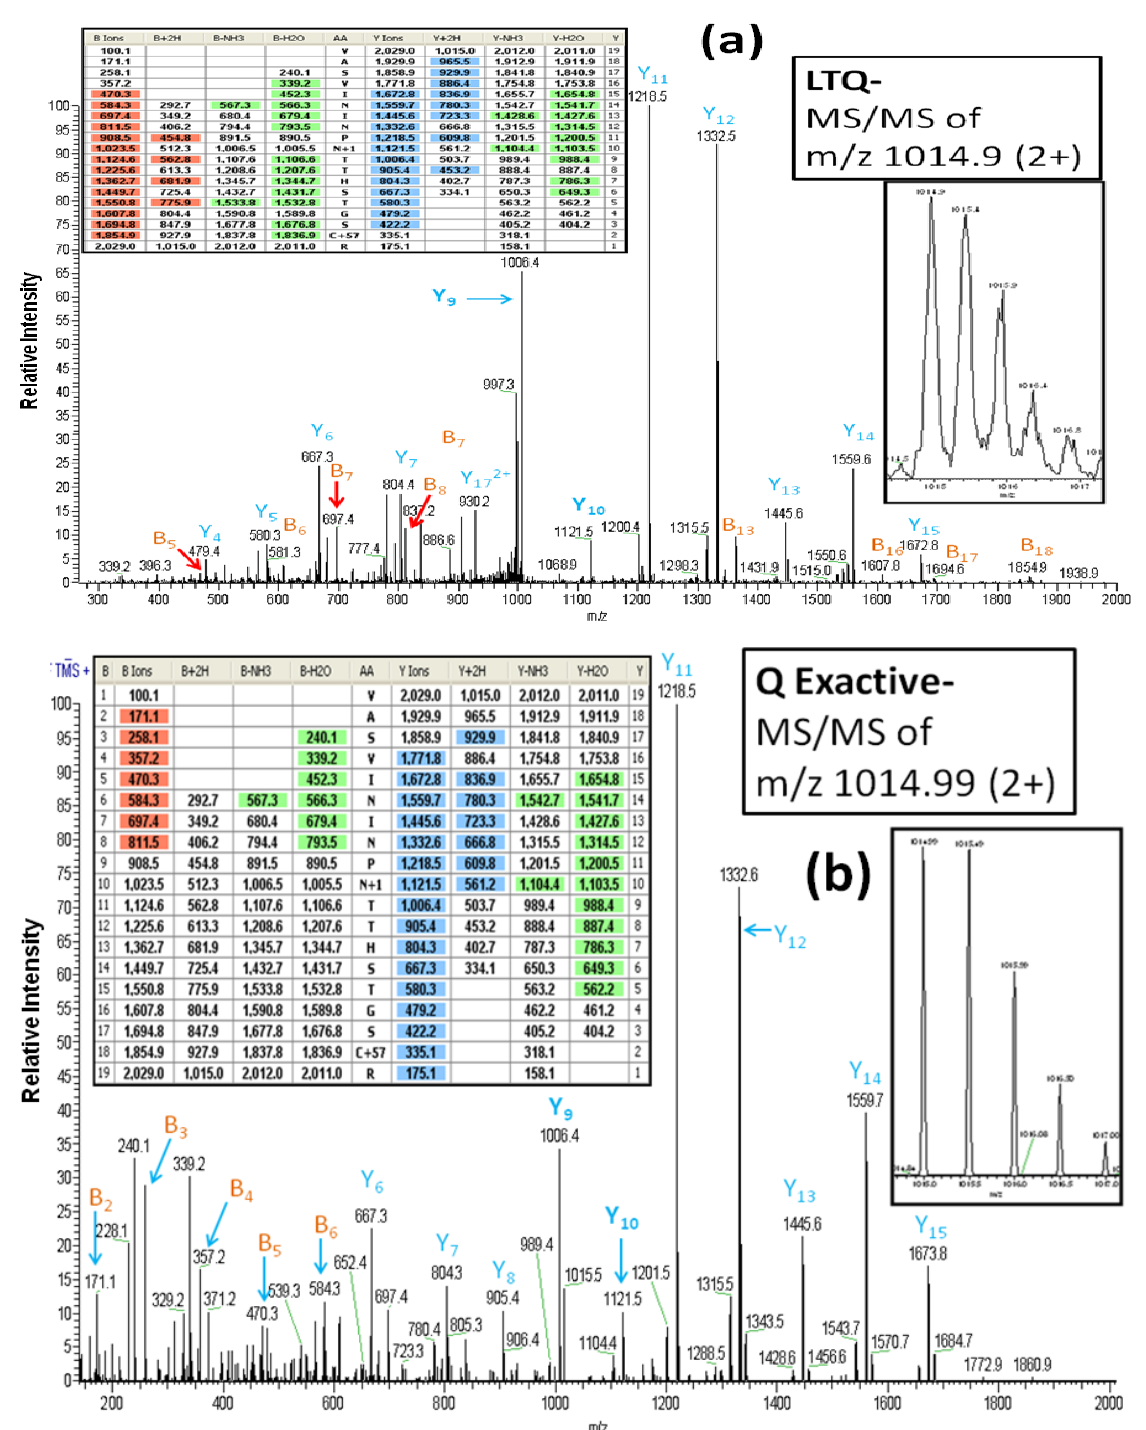
Figure 3. The LTQ MS CID-MS/MS spectrum ( a ) and the Q Exactive MS HCD-MS/MS spectrum ( b ) of the glycopeptide VASVININPN*TTHSTGSCR (AA#248-266, N* denotes a conversion of Asn to Asp for the N -linked site Asn 257 ) from lysosome-associated membrane glycoprotein 2. Both spectra contain a rich set of structural-fragments. The inset figures show the isotopic profile of the doubly charged precursor ion, and the inset tables show lists of the color-coded fragments matching the expected values for various ions. B and Y denote the N -terminal and the B-terminal fragments, respectively. The MS/MS n fragment nomenclature used is according to Johnson et al.